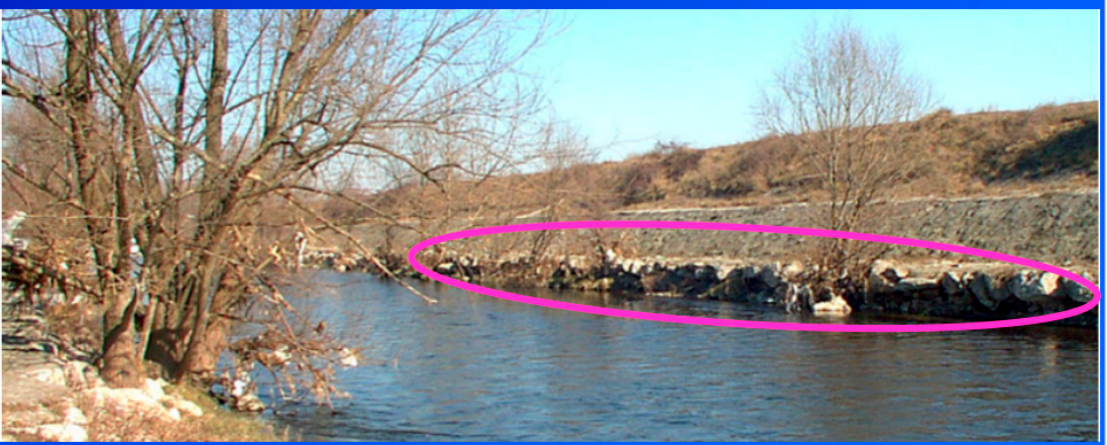
Figure 4. An example of consumption of the “work-in-good-shape” capital, because of lack of maintenance and periodic replacement (river Chiese, Italy): the toe of the bank protection is disrupted (fuchsia circle) and the door of a defense collapse is ajar.